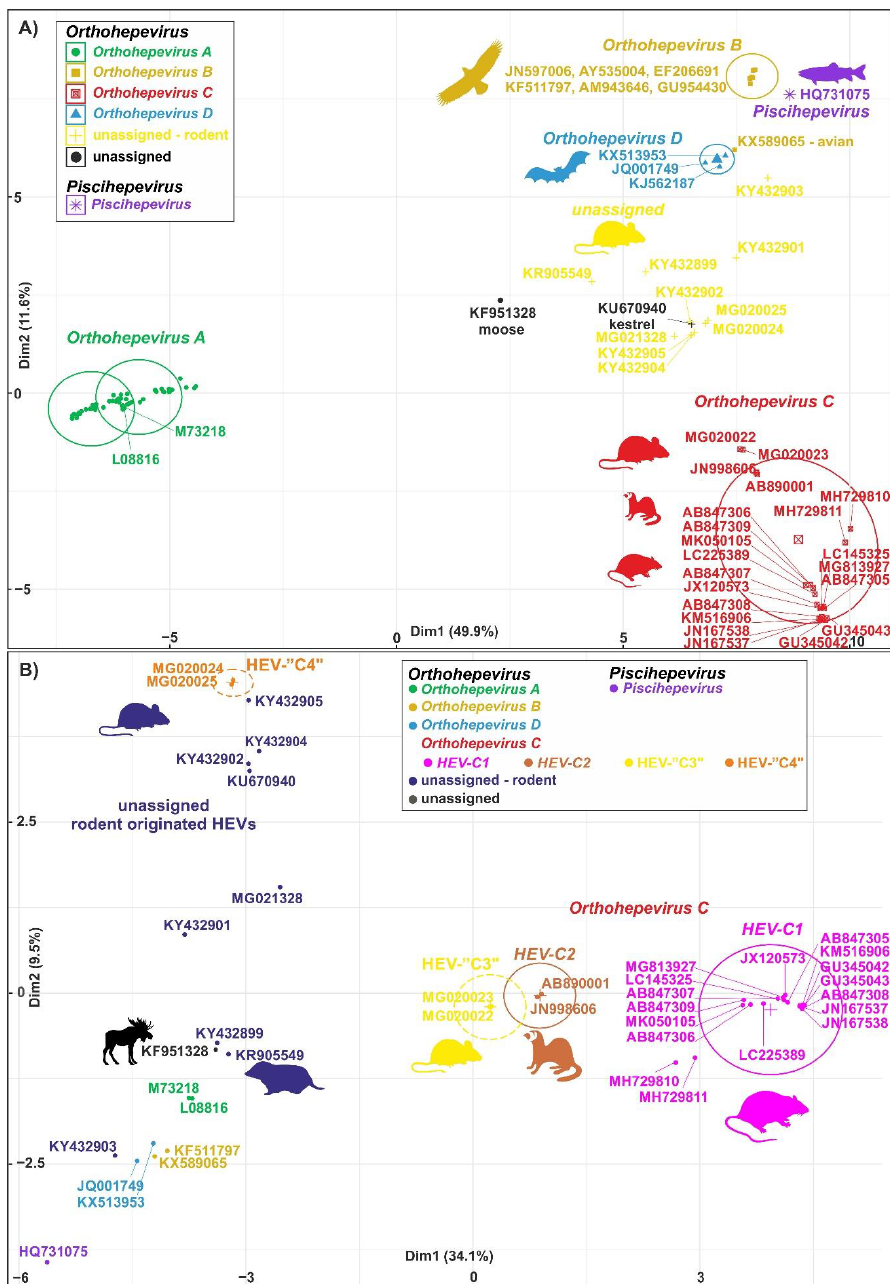
Figure 4. Cluster analysis of hepeviruses based on the complete nucleotide sequences of open reading Figure 1 (ORF1). ( A ) Plot A represents the distribution of representative hepevirus species in Hepeviridae , and ( B ) Plot B focuses on the distribution of rodent origin hepeviruses. Piscihepevirus A (purple), Orthohepevirus A (green) , B (gold) , C (red), and D (blue) and currently unassigned (yellow and black) species in Plot A and Plot B, respectively, are K-means clustered together [73]. The rodent origin hepevirus clusters in Orthohepevirus C , HEV-C1 (magenta), HEV-C2 (brown), and two novel clusters, HEV-“C3” (yellow) and HEV-“C4” (orange), are shown in Plot B. Briefly, a total of 101 and 40 complete coding sequence (CDS) of ORF1 sequences in Plot A and Plot B, respectively, are aligned by MEGA using codon based ClustalW alignment method and analyzed by R using seqinr, msa, cluster, factoextra, and randomColoR packages. An identity matrix of pairwise distances from aligned nucleotide sequences was calculated. The matrix scaled and the optimal number of clusters and the means (centres) of each cluster were estimated. The R algorithm code could be provided on